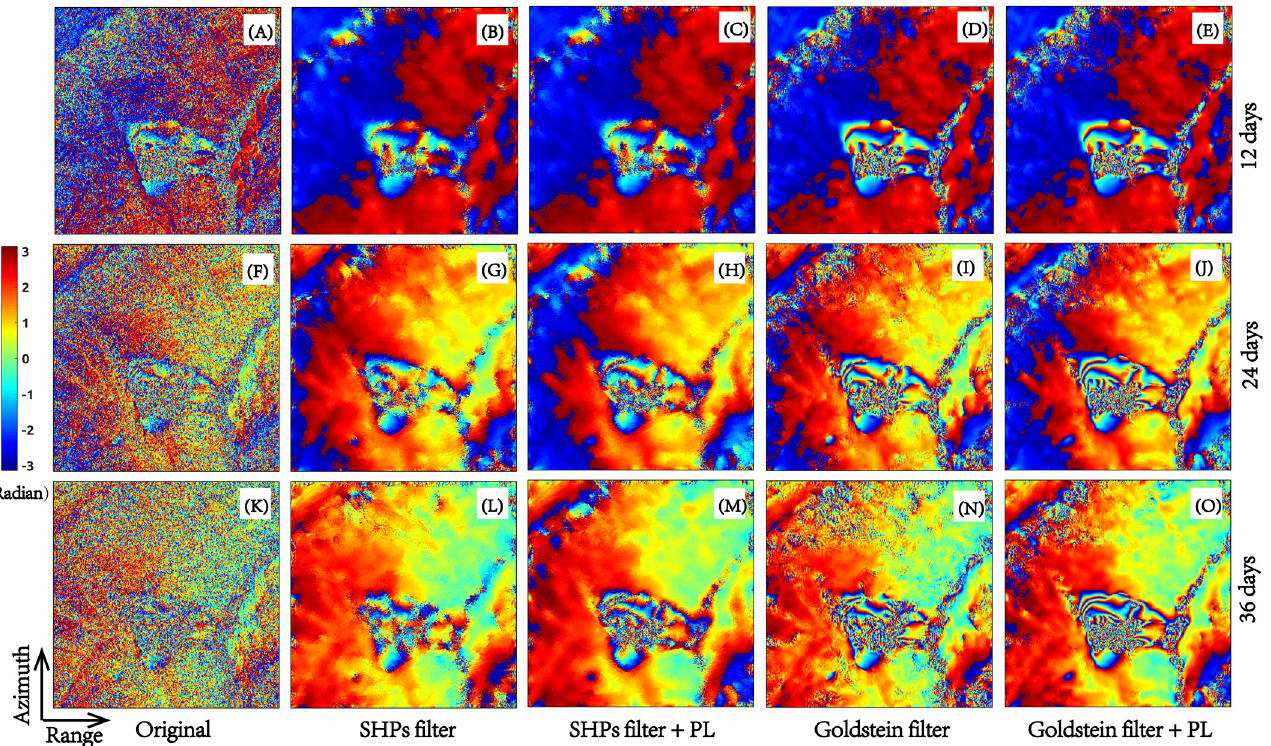
Figure 7. Comparison of interferograms filtered by different methods. ( A , F , K ) are original interfer- ograms; ( B , G , L ) are interferograms filtered by SHPs; ( C , H , M ) are interferograms filtered by SHPs and PL; ( D , I , N ) are Goldstein-filtered interferograms; ( E , J , O ) are interferograms filtered by Goldstein and PL.